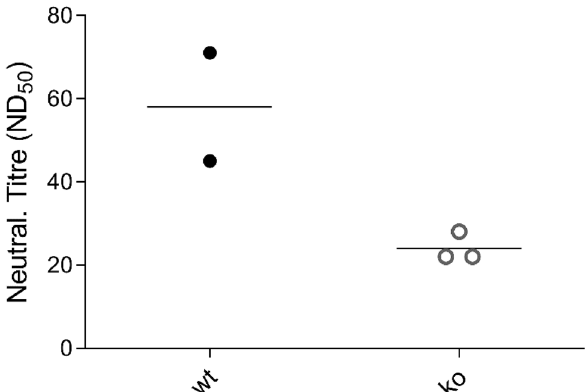
Figure 9. Antibody response of vaccinated TRDC-knockout and syngenic wild type pigs. Diagram showing the titers of virus-neutralizing serum antibodies of 2 syngenic wt (wt) and 3 TRDC-knockout (ko) pigs at day 21 post vaccination, given as the maximal reciprocal dilution of the sera that is able to neutralize 50% of 100 TCID 50 infective doses of CSFV C-strain calculated according to Spaerman-Kaerber. The mean values for both groups are shown as horizontal lines. The P value determined by statistical analysis is